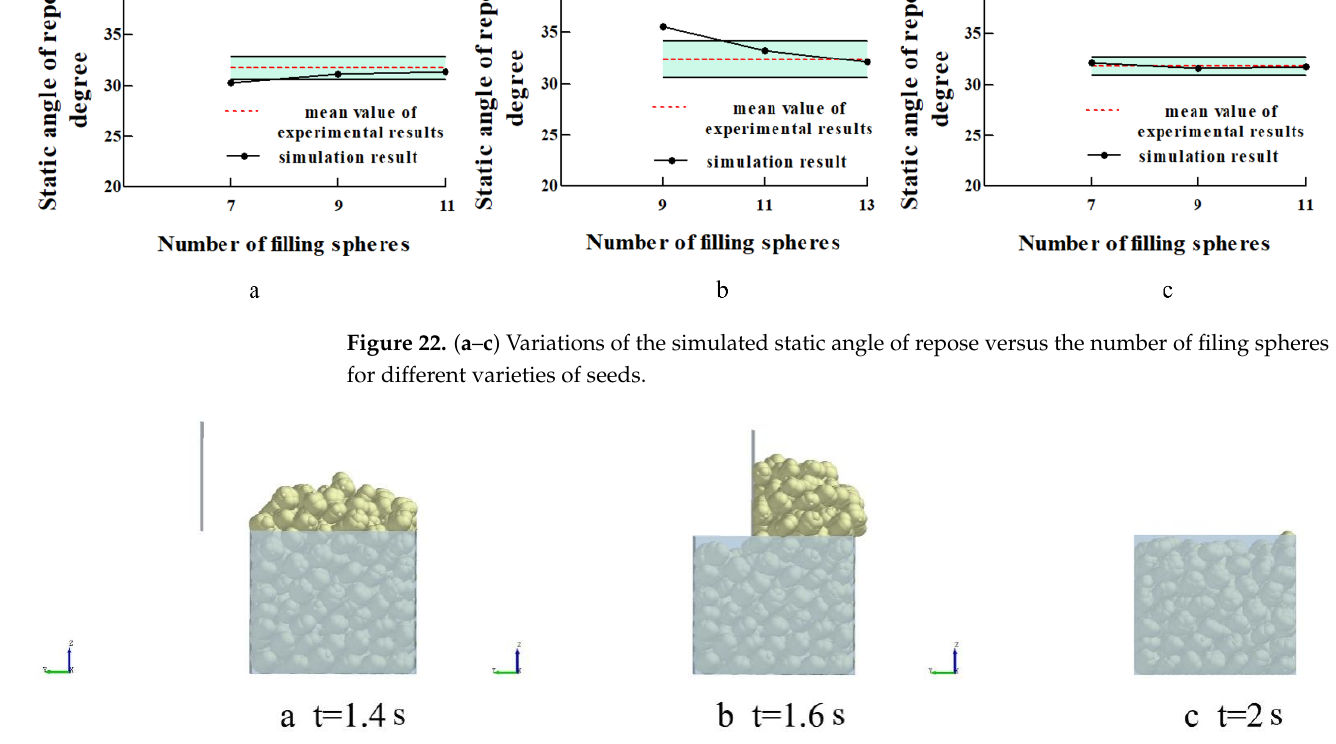
Figure 22. ( a – c ) Variations of the simulated static angle of repose versus the number of filing spheres for different varieties of seeds.